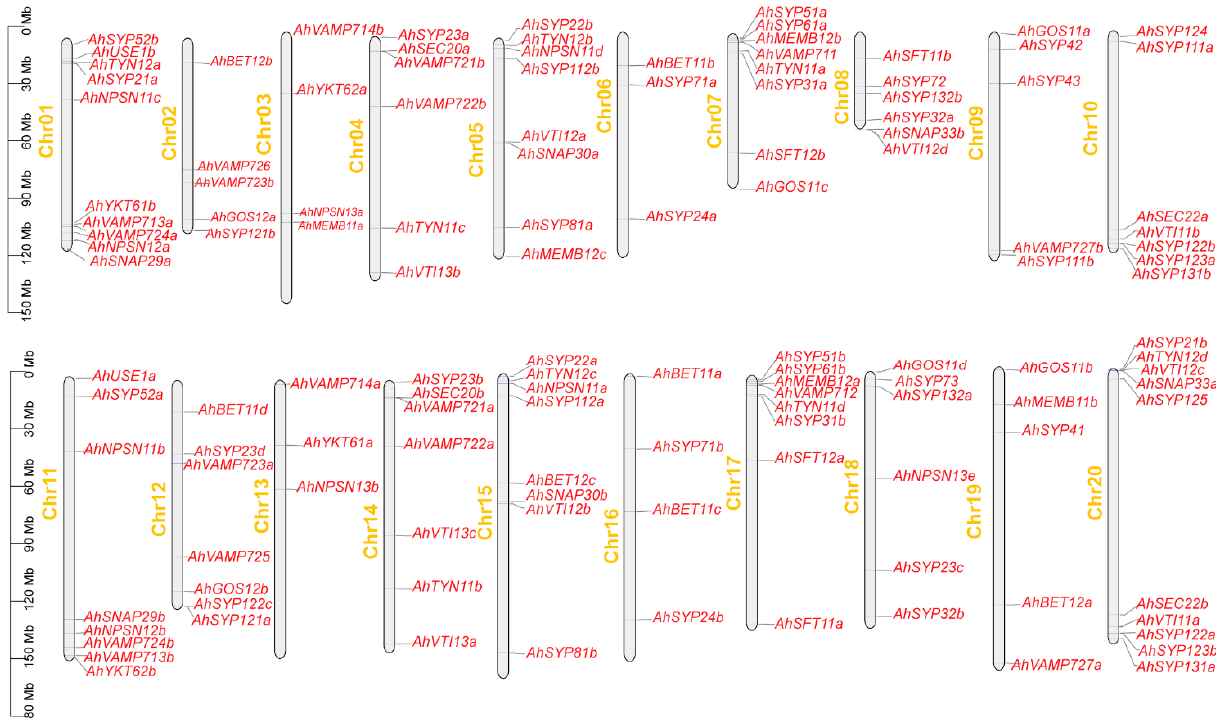
Figure 3. Phylogenetic relationships, gene structures and conserved motifs of AhSNARE genes in cultivated peanut. ( A ) Phylogenetic relationships; ( B ) conversed motifs; ( C ) exon–intron structures. Yellow boxes represent exons; gray lines represent introns.